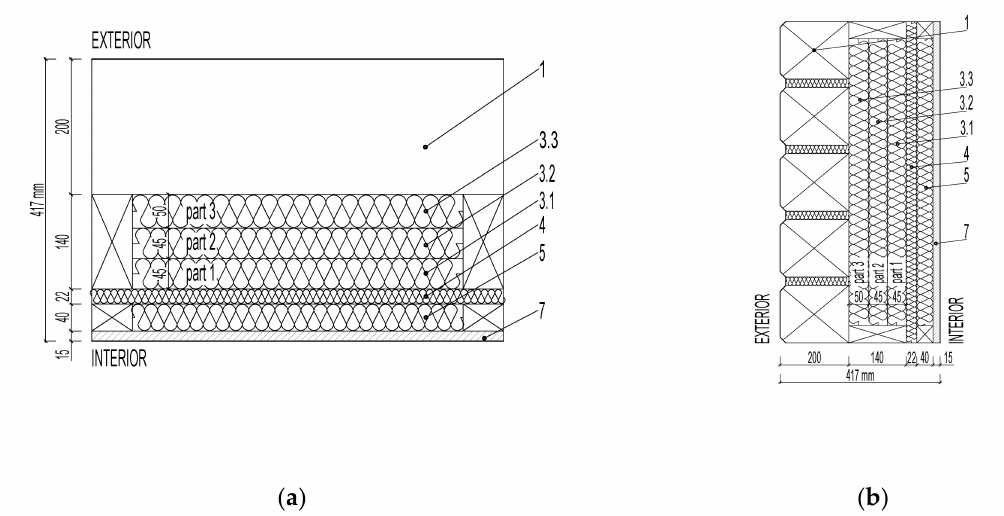
Figure 2. Log Wall LW2 without Vapor Barrier: ( a ) floor plan; ( b ) section. (1) Log Lumber; (3.1) Fiberboard Insulation STEICO Flex, part 1; (3.2) Fiberboard Insulation STEICO Flex, part 2; (3.3) Fiberboard Insulation STEICO Flex, part 3; (4) Fiberboard Insulation STEICO Universal; (5) Fiberboard Insulation STEICO Flex; (7) Interior